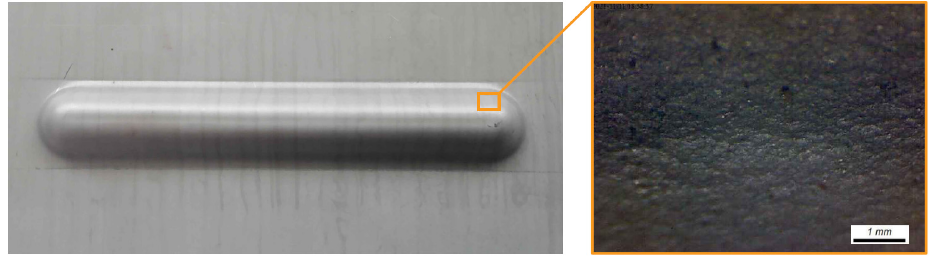
Figure 12. View of the orange peel phenomenon on the outer surface of the stiffening rib. The orange peel phenomenon was observed at the ends of the stiffening ribs in the middle of their height, and this is how the plastic deformation of the composite facings took place most often. This is confirmed by the cross-section view of the embossing presented in 13. Figure 13.